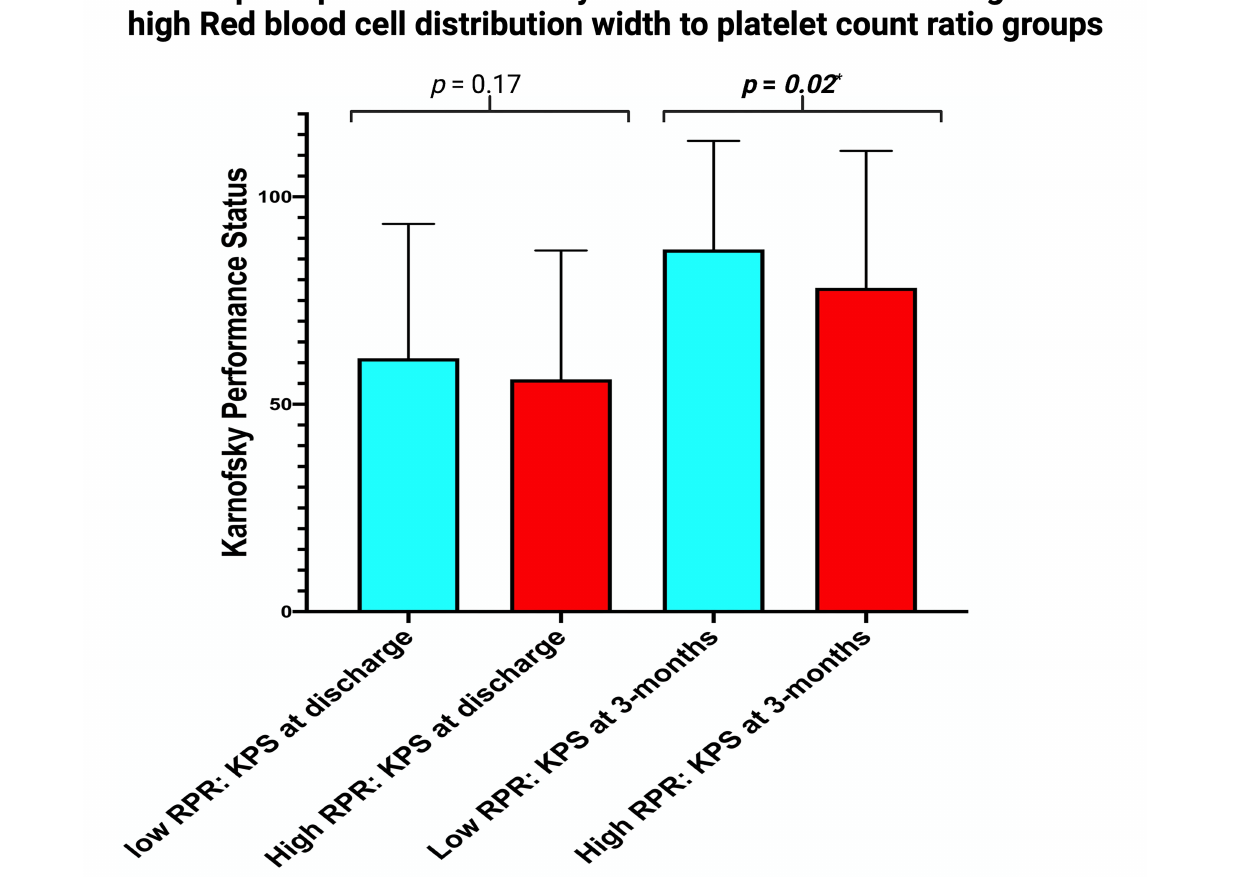
FIGURE 3 | Column bars displaying the mean value of KPS stratified by the parameters “low RPR” (light blue) and “high RPR” (red) at discharge and after 3 months. The whiskers represent the standard deviation. p -Values of the paired t -test comparing the mean values are